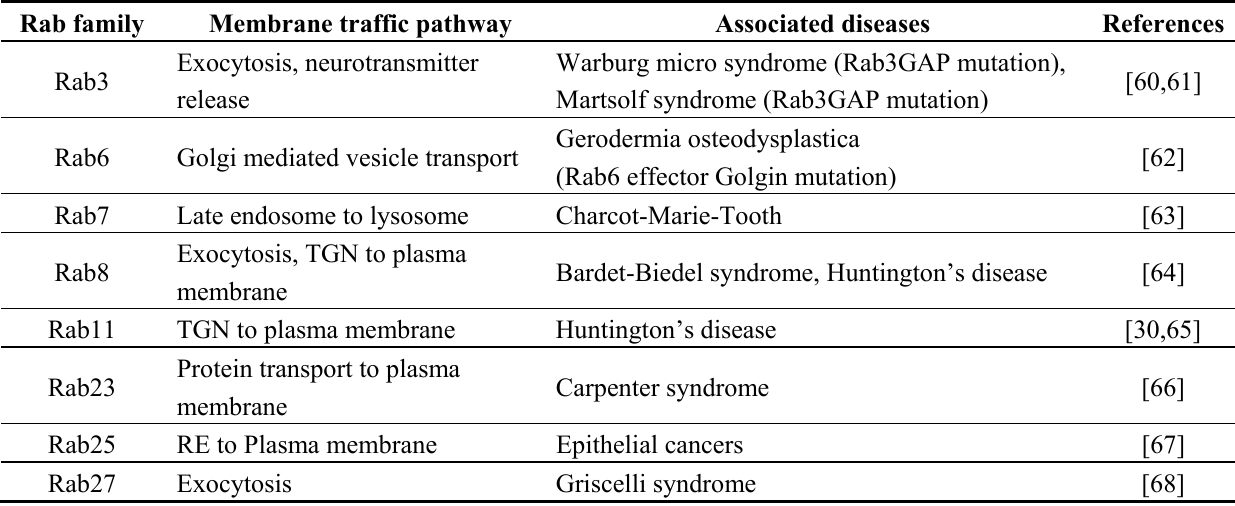
Table 2. A few examples of disease-related Rab family and associated diseases. Rab family Membrane traffic pathway Associated